Question: Name the type of graph shown.
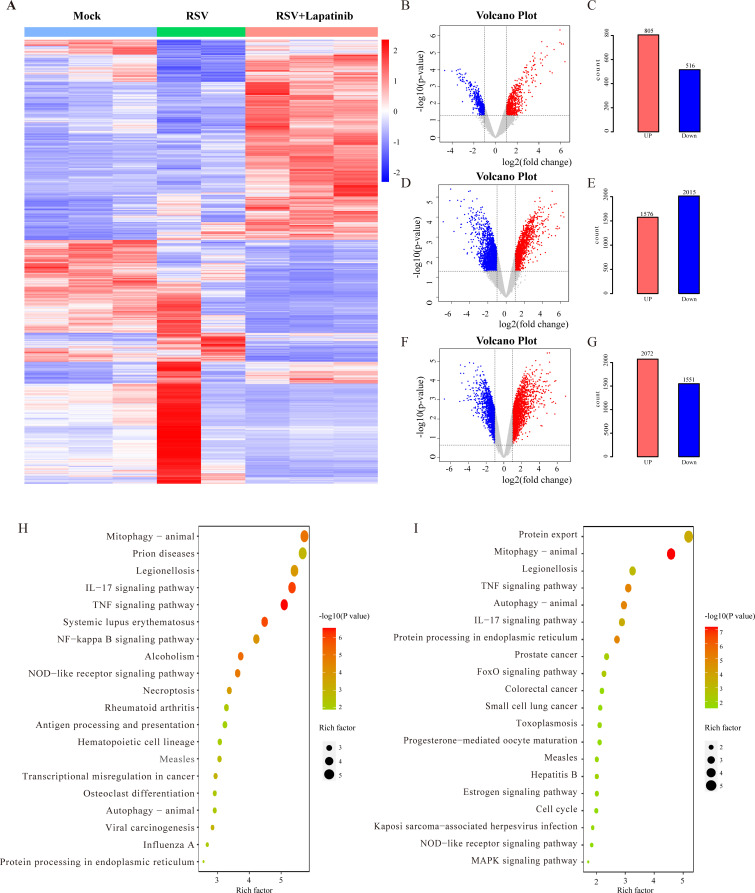
Answer: heatmap